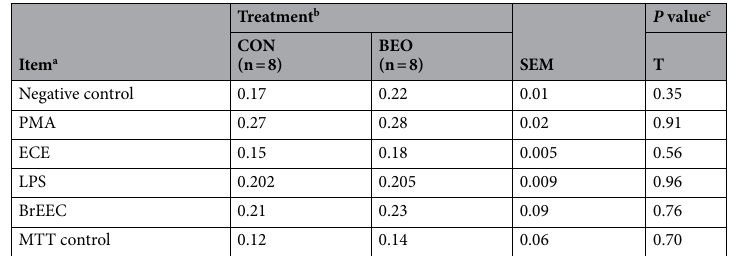
Table 7. Splenocytes proliferation assay of control bull calves (CON) and bull calves supplemented with a blend of essential oils (BEO) in milk replacer from 4 to 60 days of age. a PMA = Phorbol 12-myristate 13-acetate; positive control of the proliferation; ECE = E. coli extract; LPS = E. coli lipopolysaccharide extract from Sigma) ; BrEEC = ECE control. b CON = control; BEO = 1 g/calf/day blend of essential oil. c T = treatment effect.